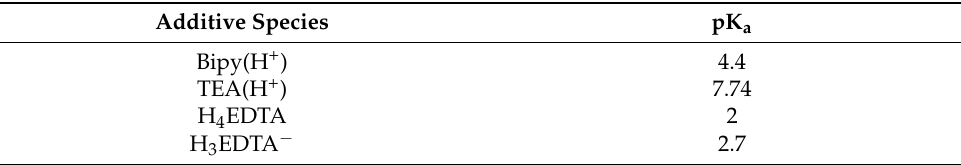
Table 3. Acid dissociation constants of selected ligand species at 298 K